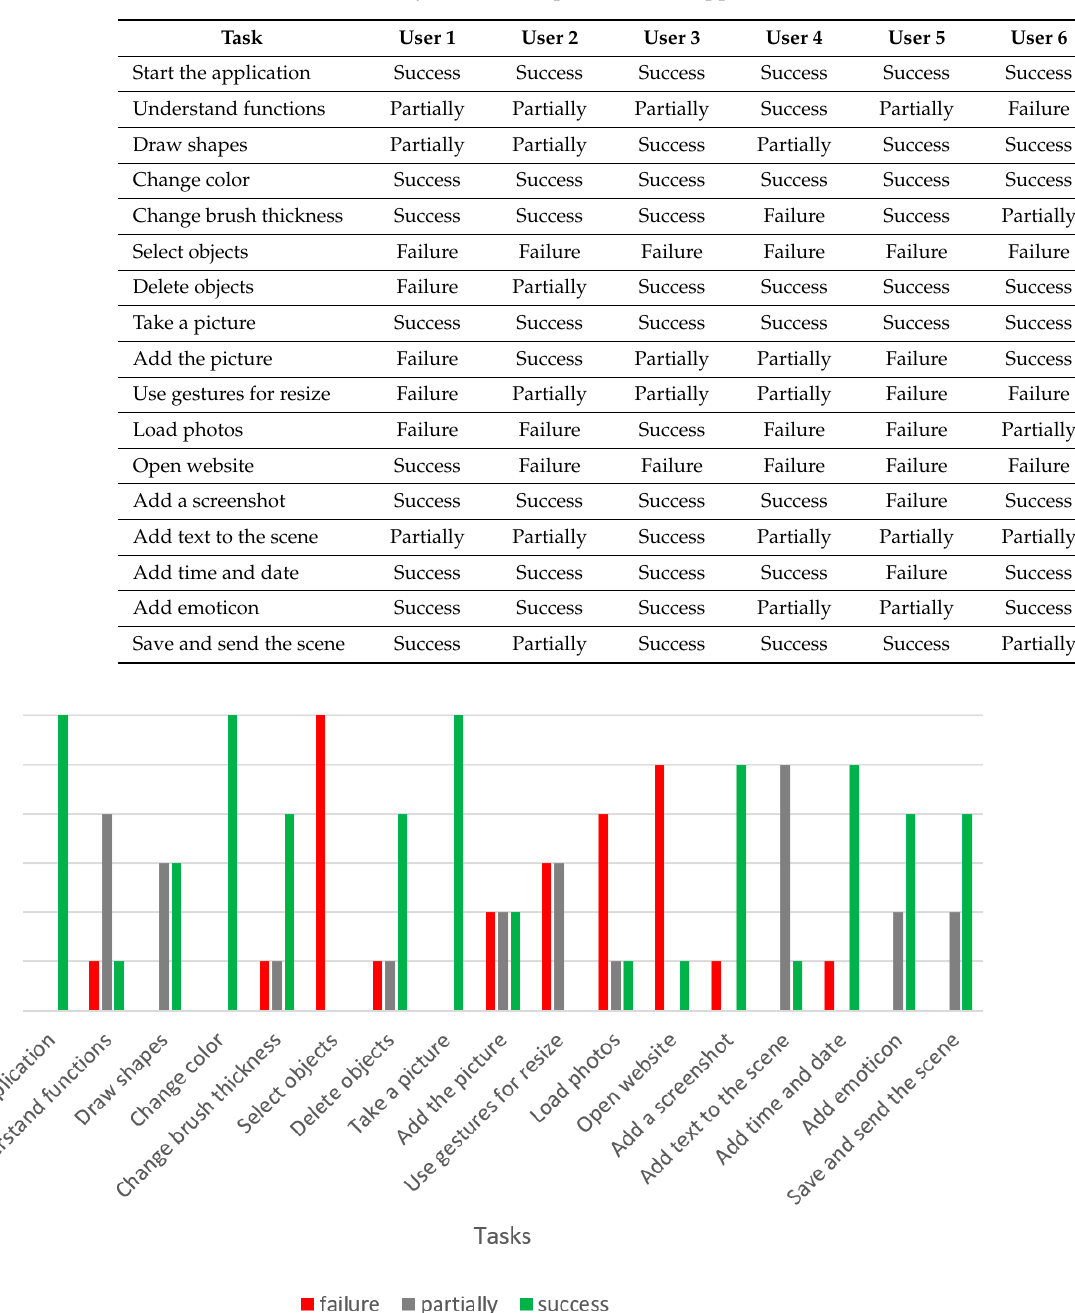
Table 2. Results of the usability test of the Aphasia Create application.